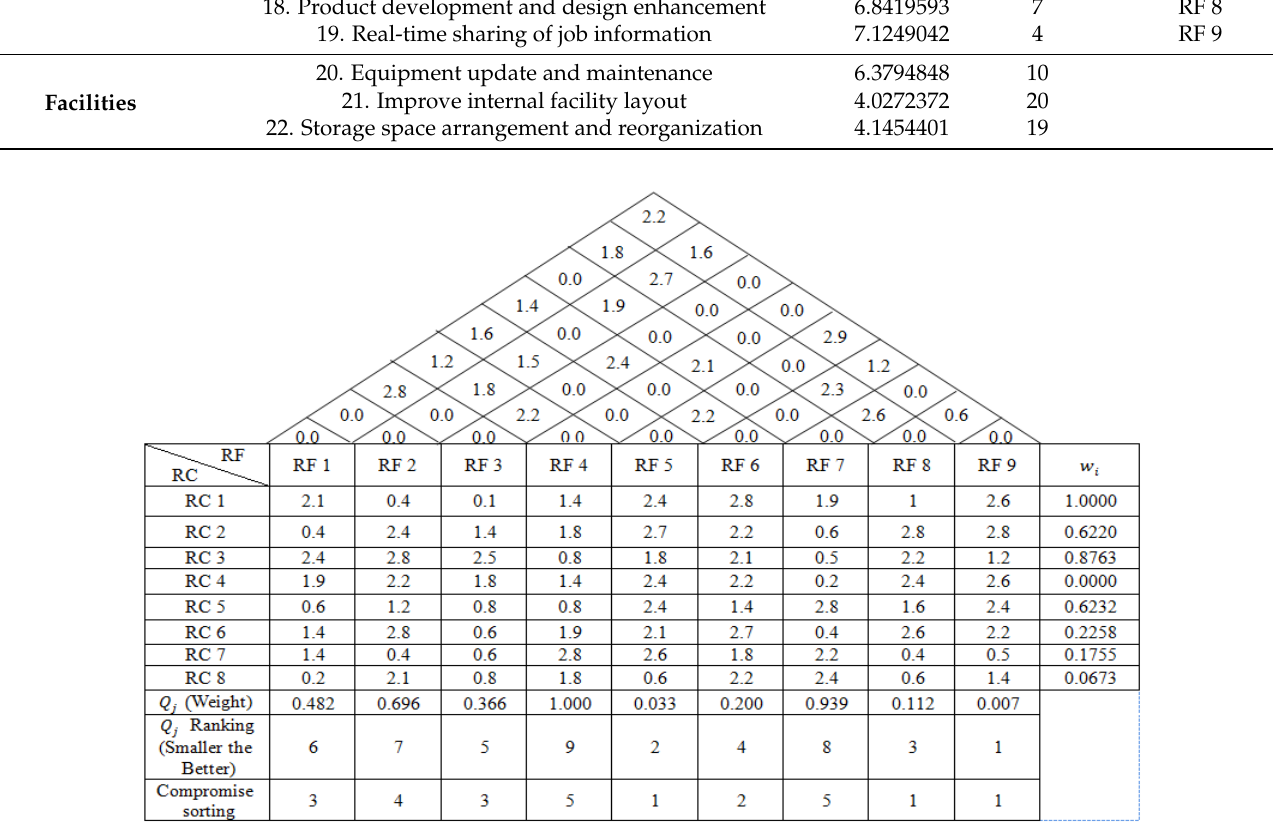
Table 15. Compromise sorting of RFs.